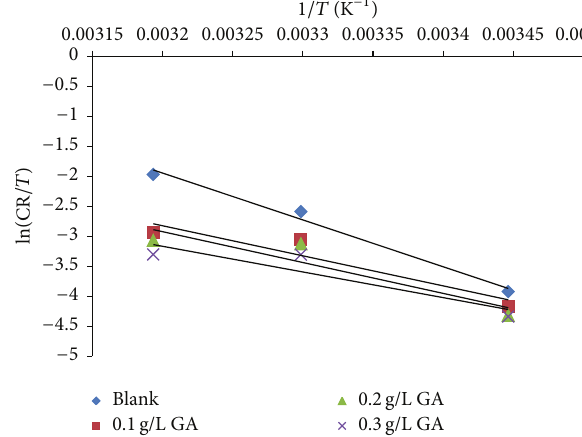
Figure 7: Transition state plot of the corrosion rate for mild steel in 1M HCl with and without GA.